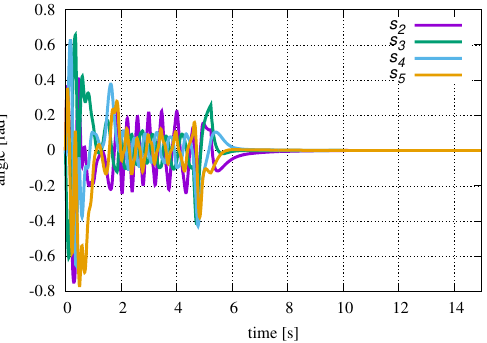
Figure 19. Case 2: Time variation of the twist angle of the